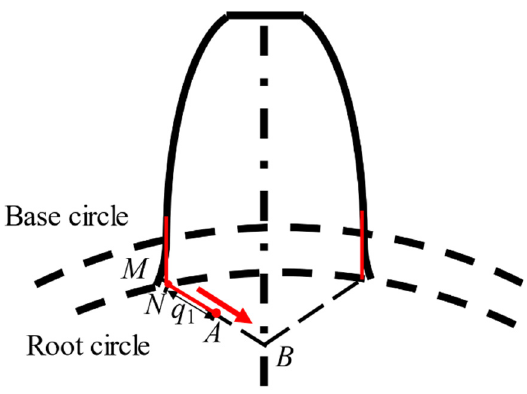
Figure 5. The schematic of a sun gear tooth with root fillet crack [20].